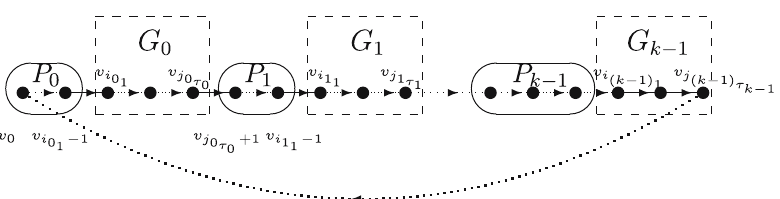
Figure 6: A round purely local tournament D which is strong with k maximal cross - arc chains and k maximal pure subpaths.